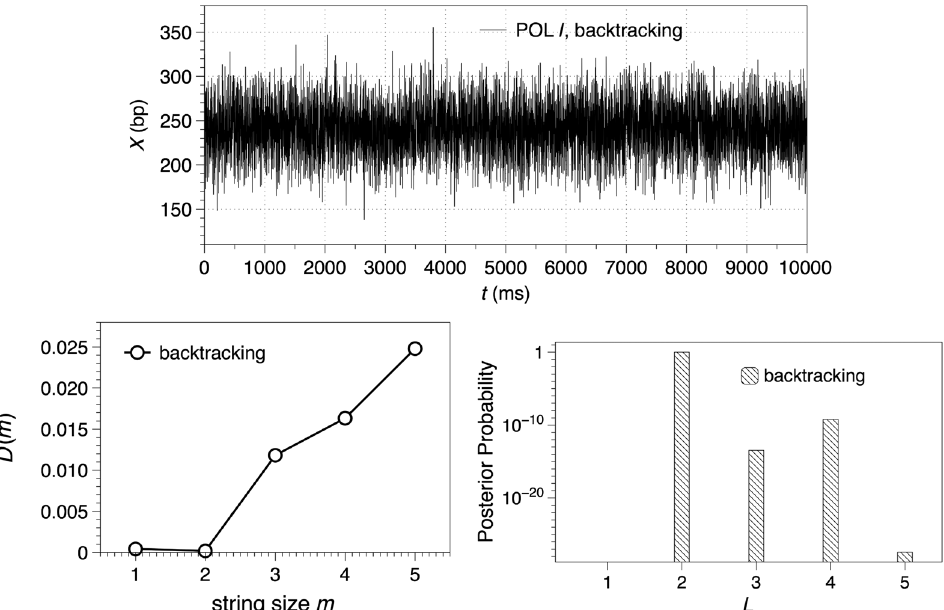
FIG. 24. (Top panel) Sample of Pol I trajectory of 10 4 steps in a backtracking pause. (Bottom-left panel) D ð m Þ as a function of m . We find D ð 3 Þ > 0 , suggesting that this series is non-Markovian. (Bottom-right panel) Posterior probability P ( L j X ð 1 ∶ N Þ ) as a function of the number of layers L , peaking at L ¼ 2 . The probability for L ¼ 1 is below the ϵ of the machine, meaning it is virtually